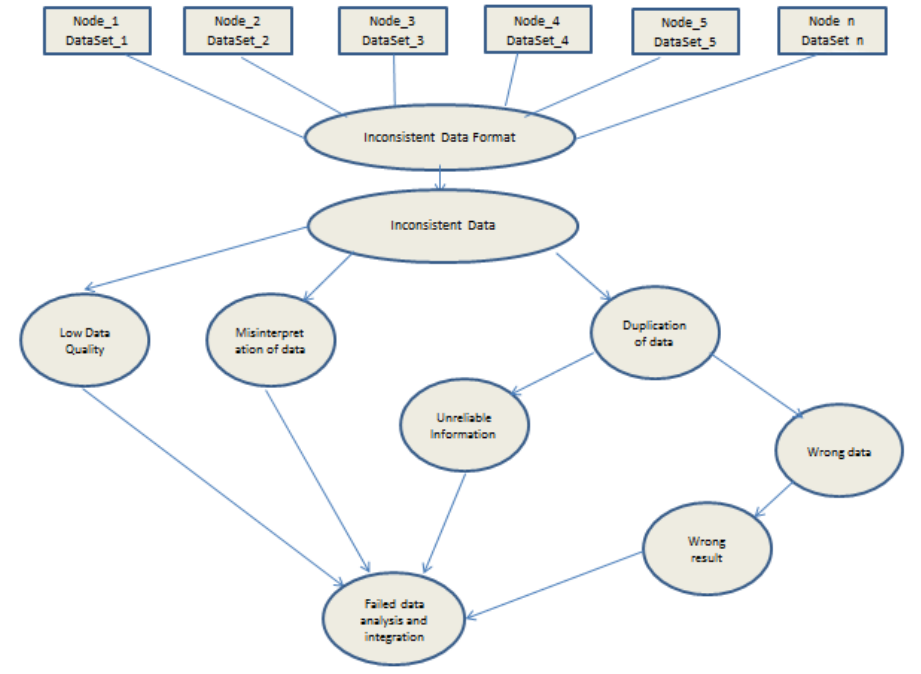
Figure 2. Risk map—dimension of data